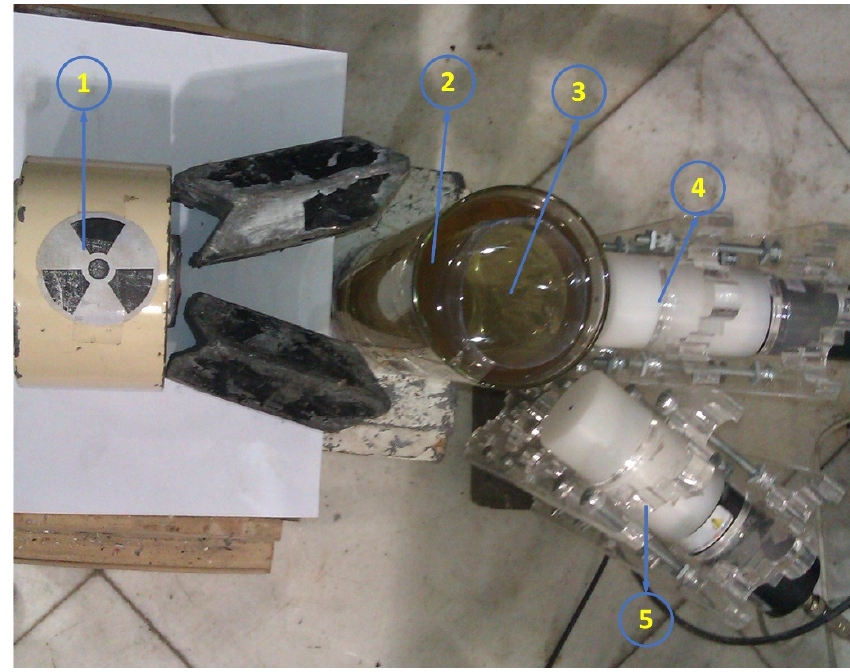
Figure 2. Experimental setup: (1) Radioisotope source, (2) Oil phase, (3) Gas phase, (4) 1st detector, (5) 2nd detector [20].